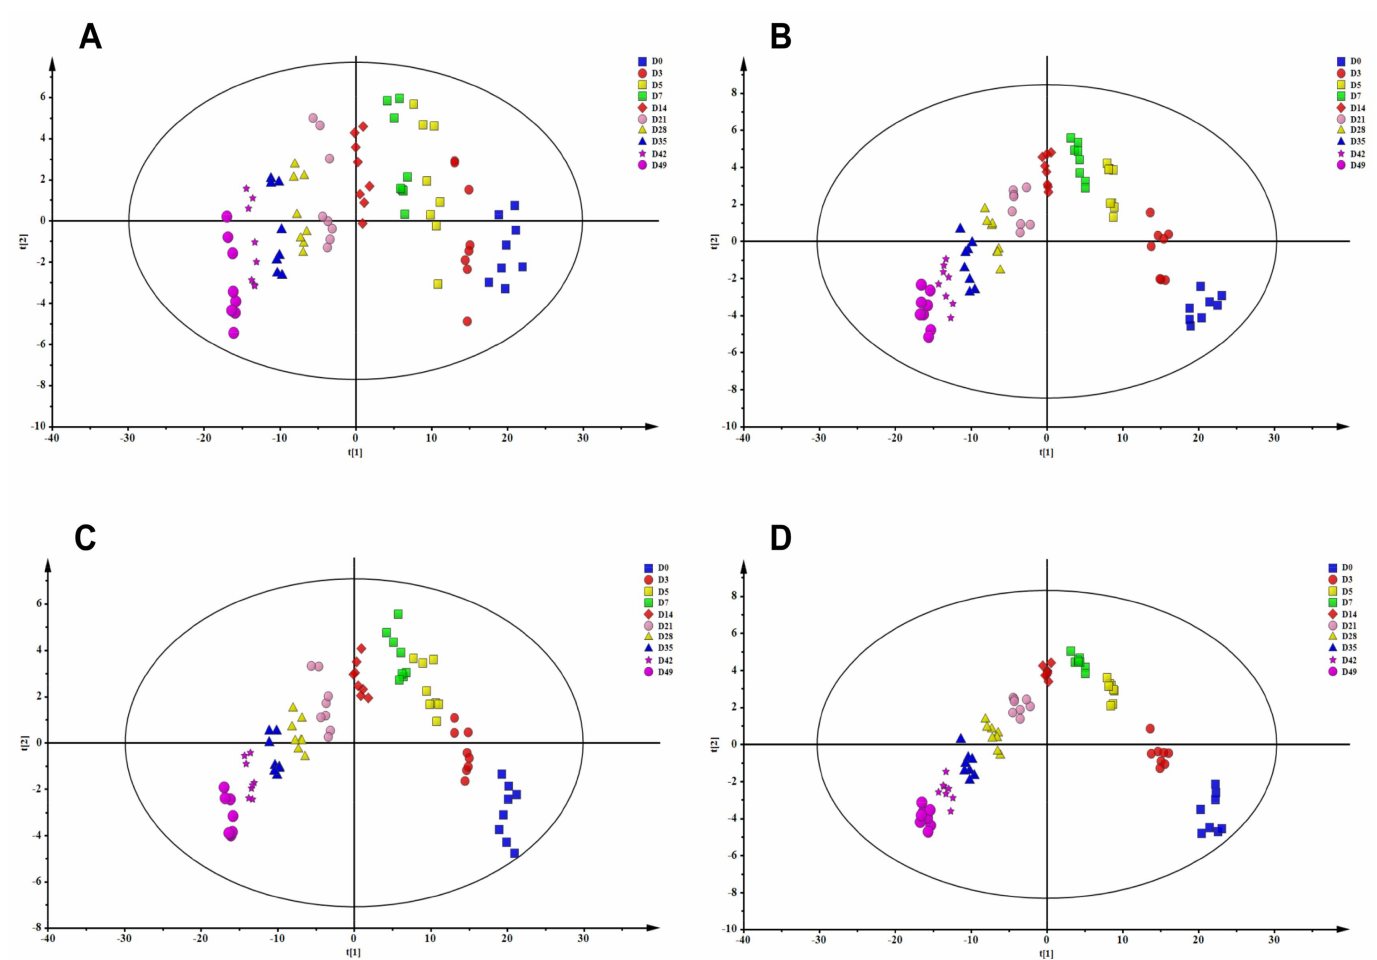
Figure 1. Principle component analysis (PCA) score plots of 10 time points MAP-stored RBCs in positive mode ( A ) and in negative mode ( B ) and PLS-DA score plots of 10 time points MAP-stored RBCs in positive mode ( C ) and in negative mode ( D